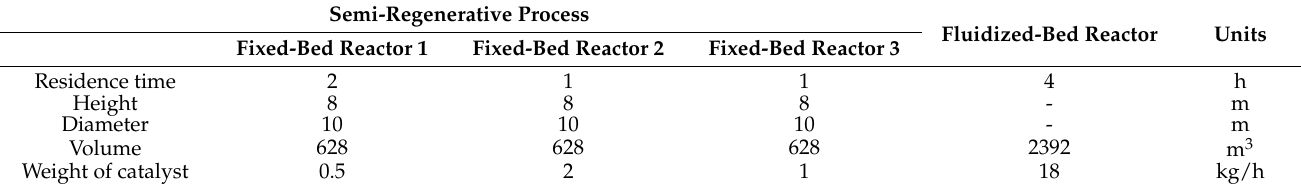
Table 5. The simulation results of semi-regenerative process and fluidized-bed